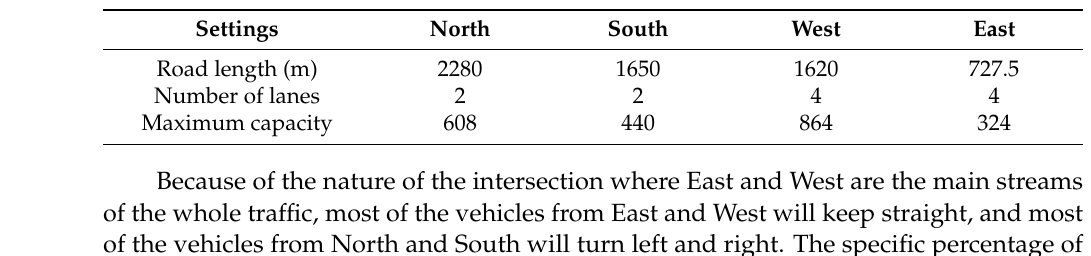
Figure 4. Route authority of the intersection. Table 1. Information of intersection.